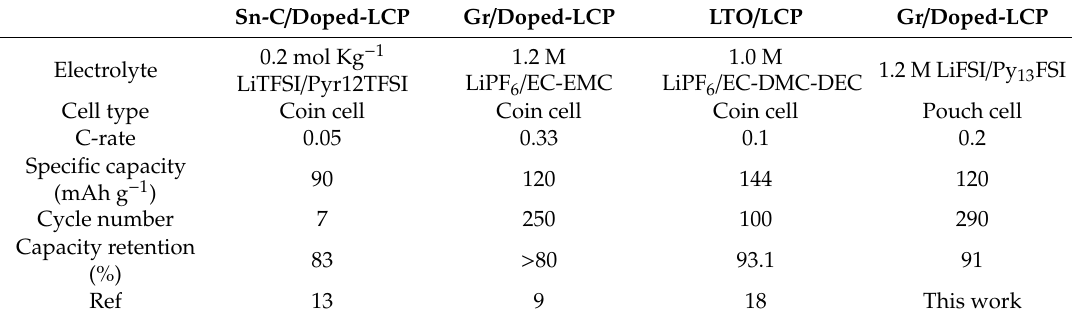
Figure 1. Voltage profiles of the 1.2 Ah graphite/LiFSI-Py 13 FSI/LCP pouch cell under 0.2 C rate ( a ); cyclability of the 1.2 Ah LCP pouch cell under 0.2 C rate ( b ); Nyquist plots of the 1.2 Ah LCP pouch cell every 20 cycles at the end of discharge during cycling ( c ) and rate performance of the 1.2 Ah LCP pouch cell at 25 ◦ C ( d ). Table 1. Comparison of performances of the 5 V LiCoPO 4 pouch cell and the full cells reported in